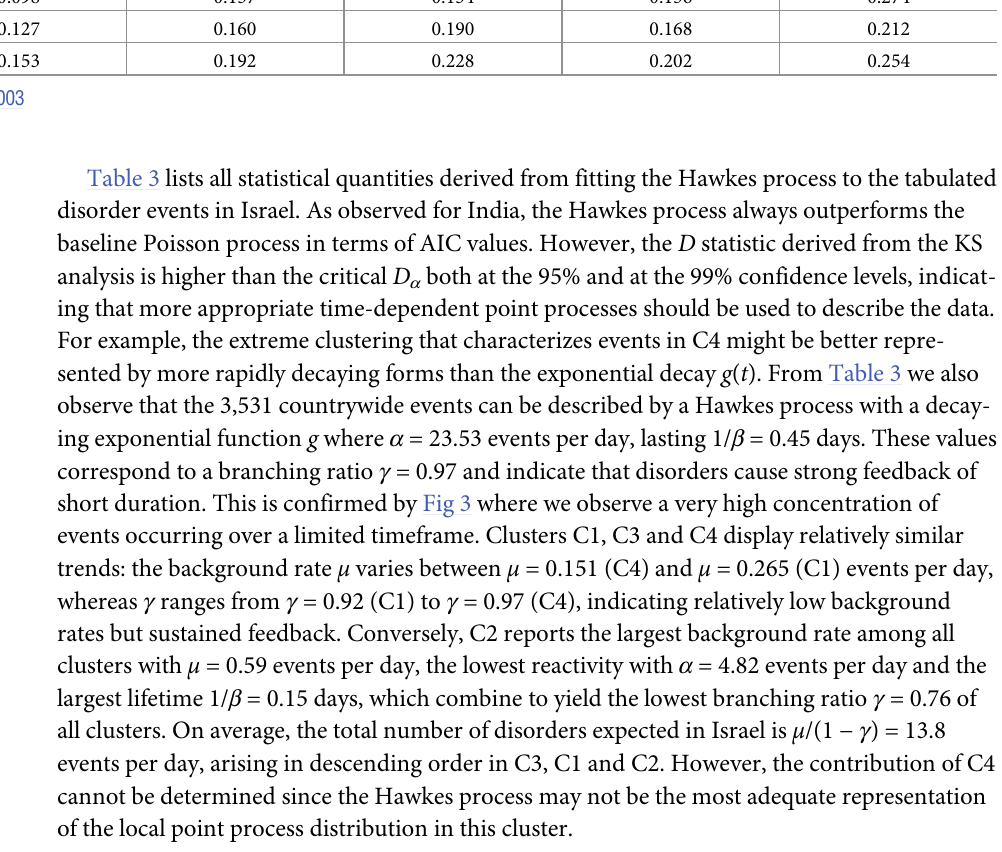
Table 3 lists all statistical quantities derived from fitting the Hawkes process to the tabulated